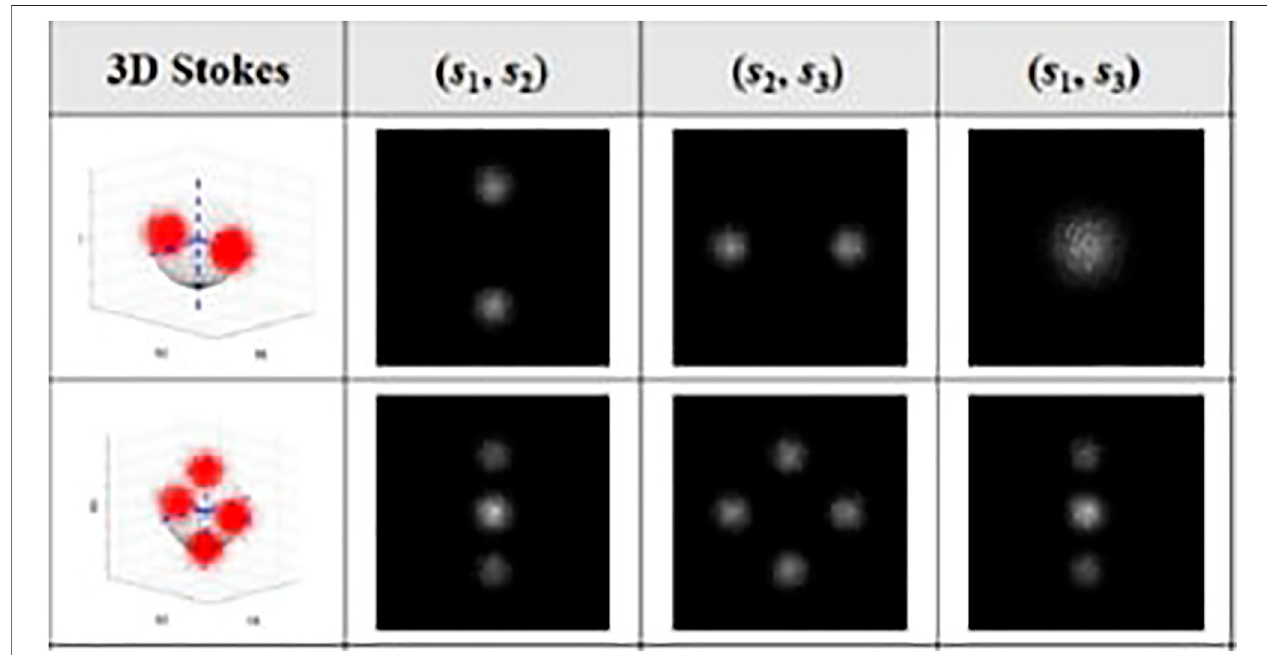
FIGURE 10 | 3D Stokes constellation of a BPSK and QPSK signal, as well as their corresponding projections in the 2D Stokes planes at OSNR (cid:1) 18 dB (Zhang et al., 2020).